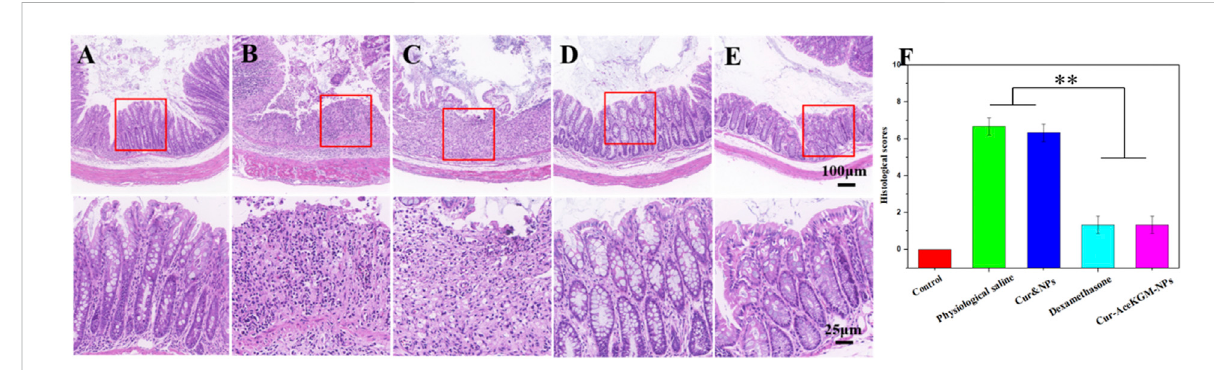
FIGURE 8 Histological analysesofcolonsectionsstainedwithH&Efromthecontrolgroup (A) ,physiologicalsalinegroup (B) ,physical mixtureCurandNP group (C) , dexamethasone group (D) , and Cur – AceKGM NP group (E) , respectively. (F) Corresponding histological scores. All the experiments were performed in triplicate; data are shown as mean ± SD. ** p <